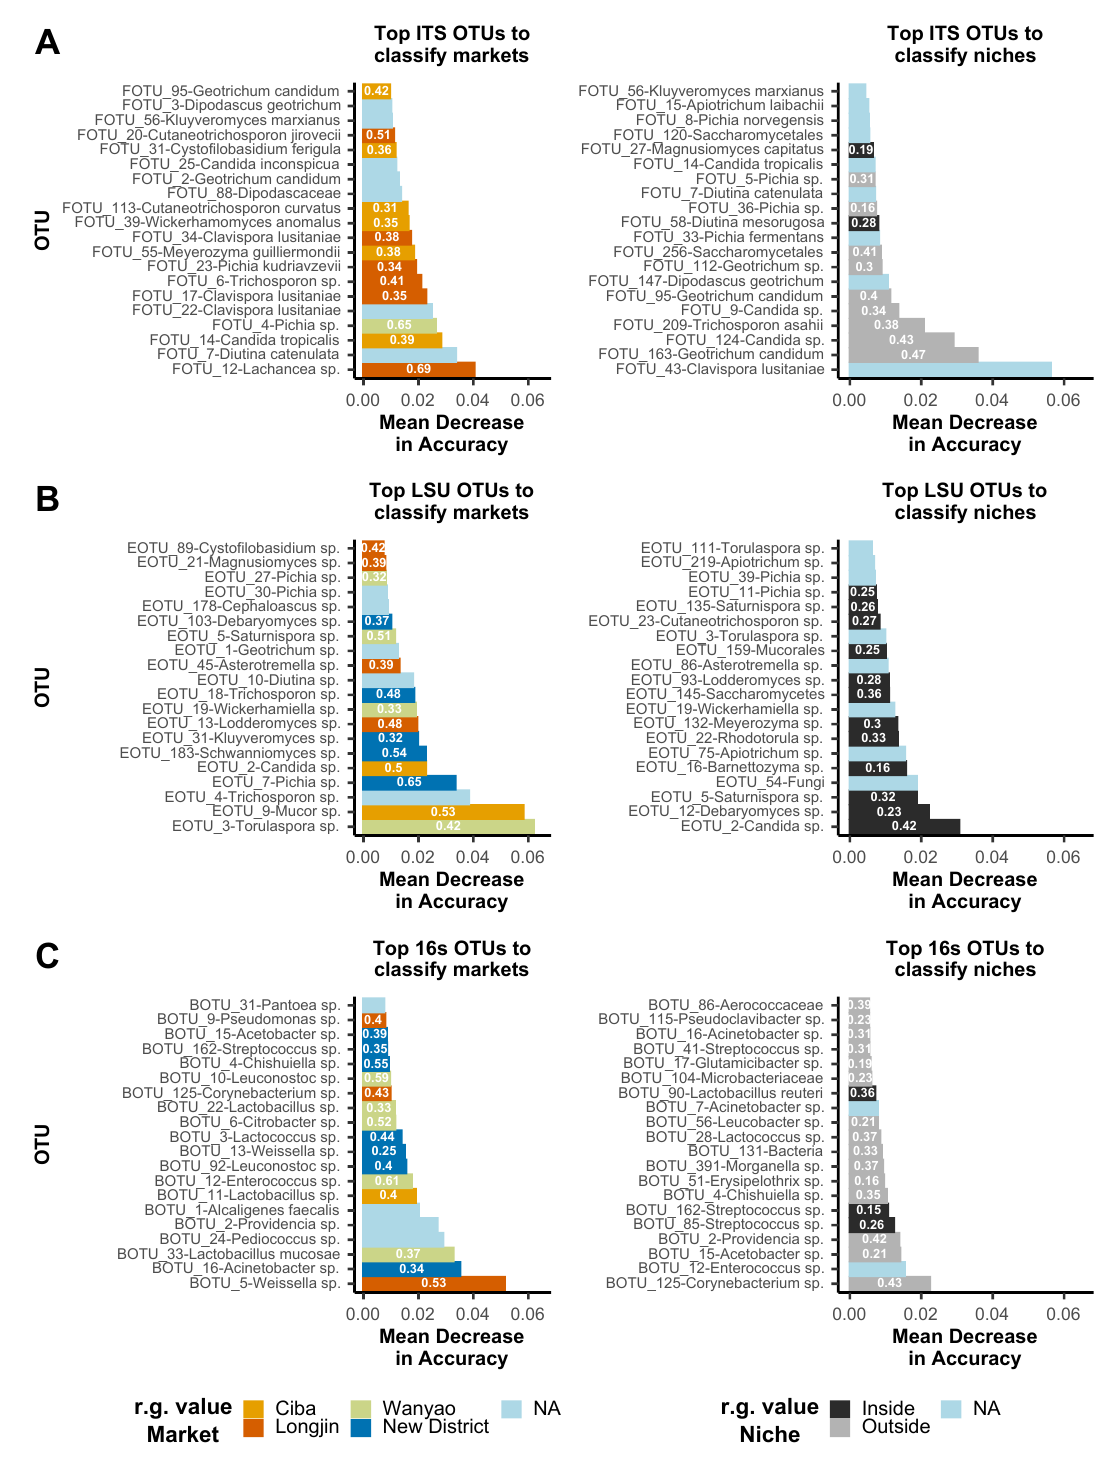
Figure 5. Top 20 OTUs with the highest mean decrease accuracy obtained in the random forest models for the ( A ) ITS, the ( B ) LSU, and ( C ) 16S rDNA marker datasets. Significant (with p ≤ 0.05 after fdr correction) correlations (i.e., r.g. value) with samples of different markets or niches (sample from external or internal part of tofu) are reported within each bar, while colors specify the sample groups that OTUs are correlated